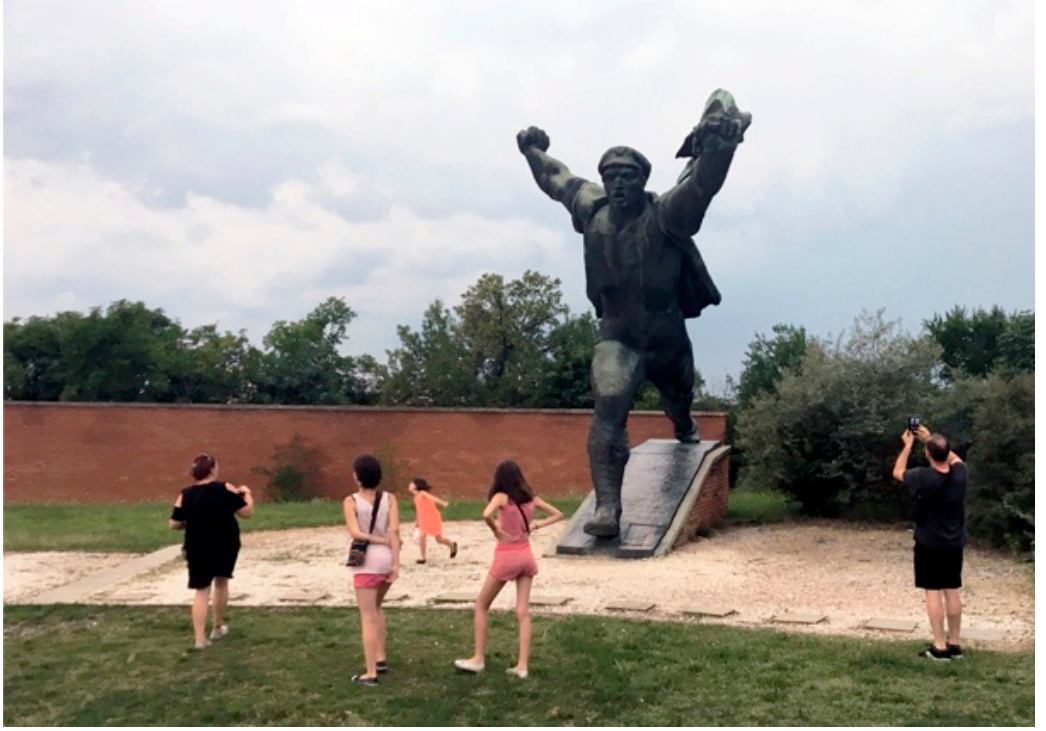
Figure 3. Tourists visiting Memento Park in Budapest. Author’s photo, 2018-08-05.